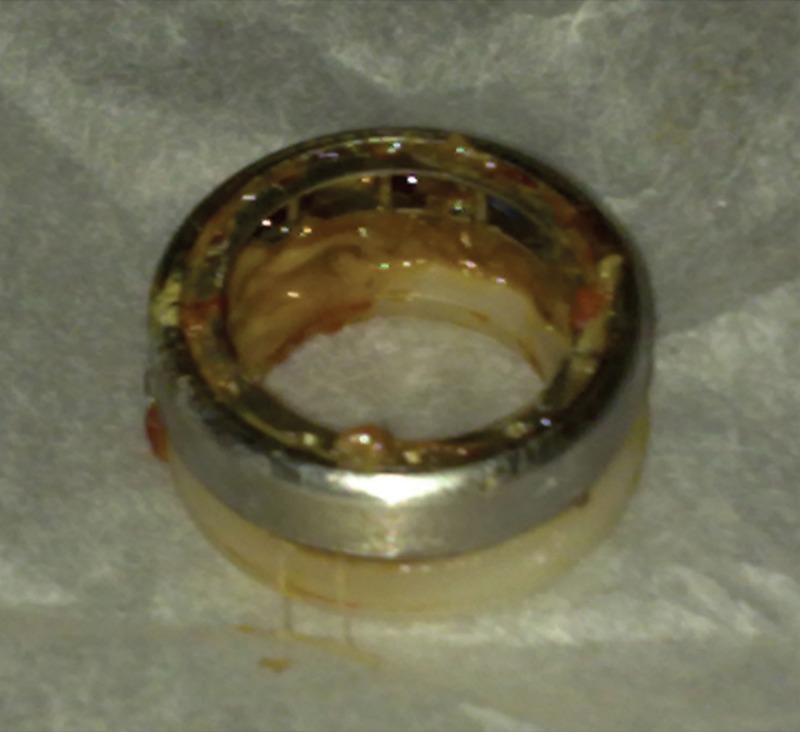
The evacuated NiTi compression anastomosis ring (NiTi CAR 27).